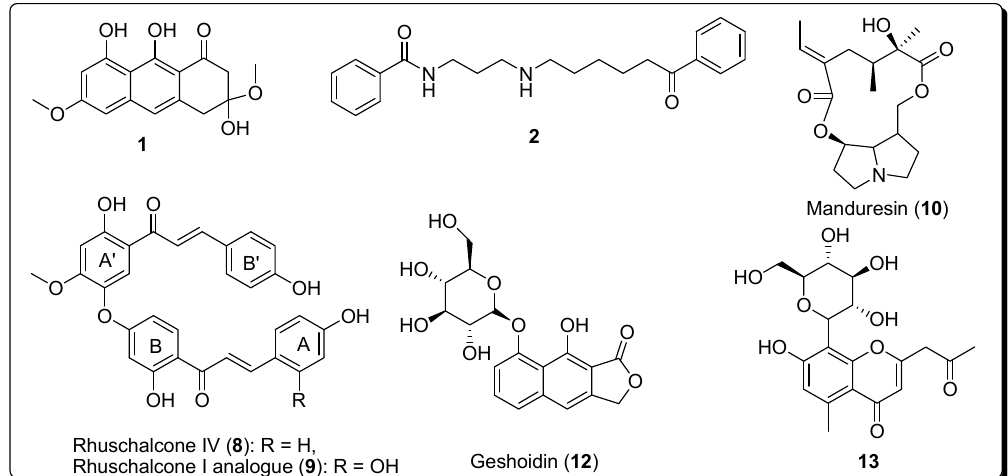
Figure 1. Compounds tested against sirt1, 2 and 3.